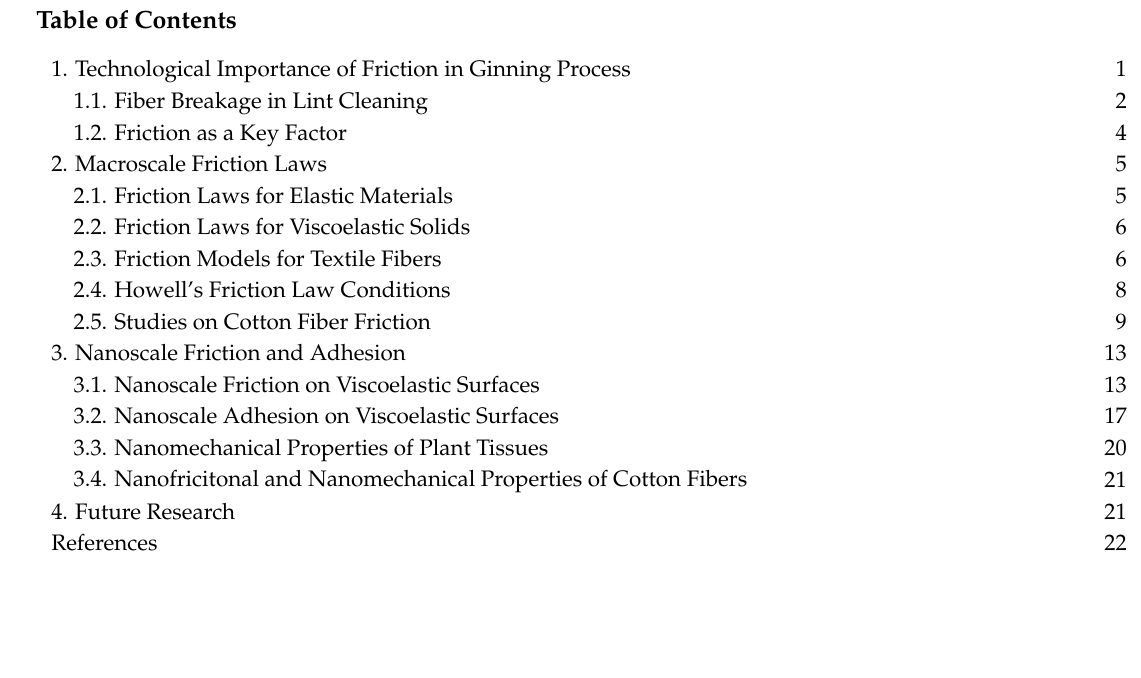
1. Technological Importance of Friction in Ginning